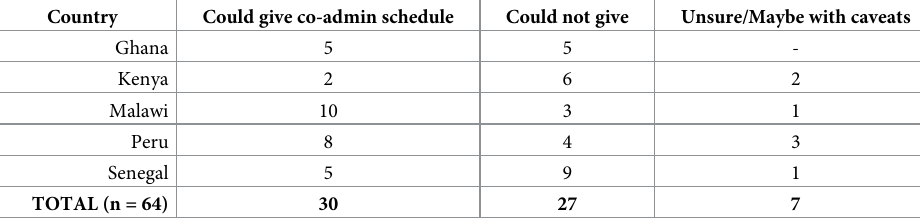
Table 8. Healthcare provider responses for delivering an LORV + iNGRV co-administration schedule. Country Could give co-admin schedule Could not give Unsure/Maybe with caveats